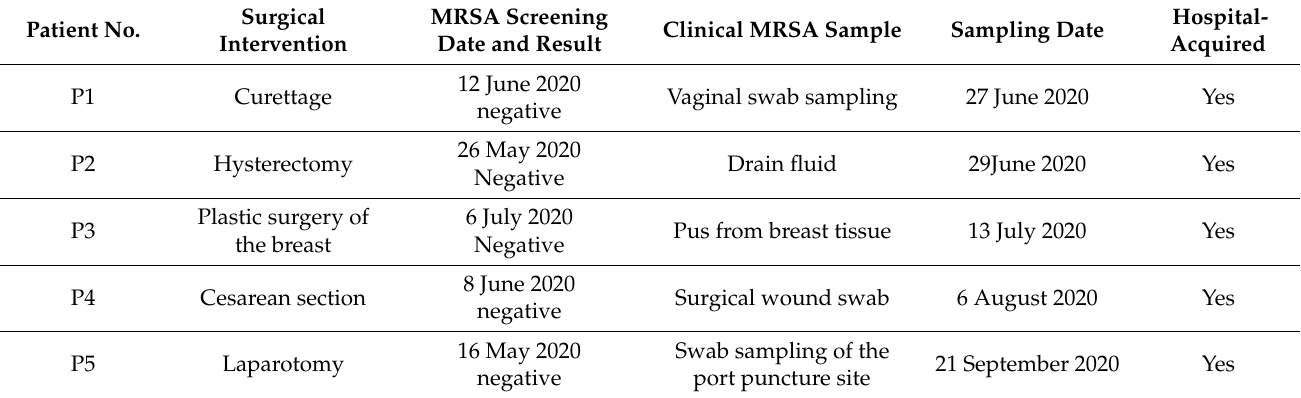
Table 1. Clinical characteristics of methicillin-resistant S. aureus (MRSA) infected patients. Patient No.